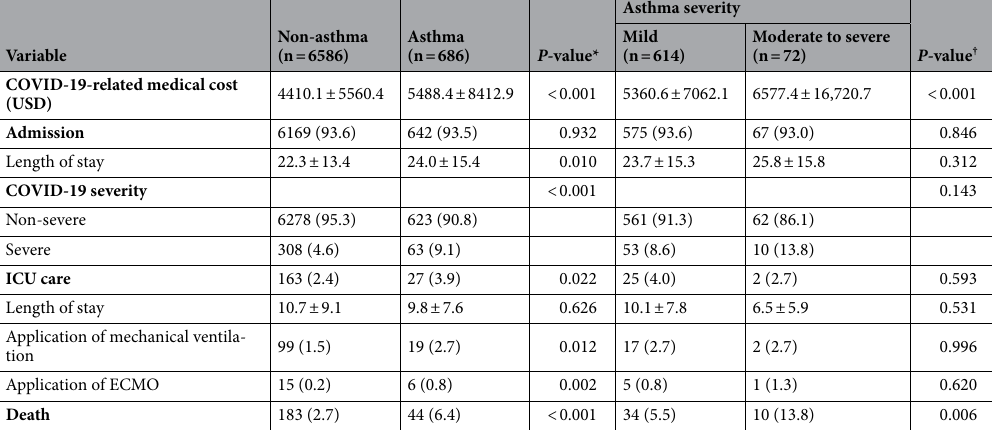
Table 2. Clinical outcomes of coronavirus disease between asthma and non-asthma groups. Data are presented as numbers (%) or means ± standard deviations. * P -value for comparison between asthma and non- asthma groups. † P -value for comparison between mild and moderate-severe groups. COVID-19, coronavirus disease; USD, United states dollar; ICU, intensive care unit; ECMO, extracorporeal membrane oxygenation.